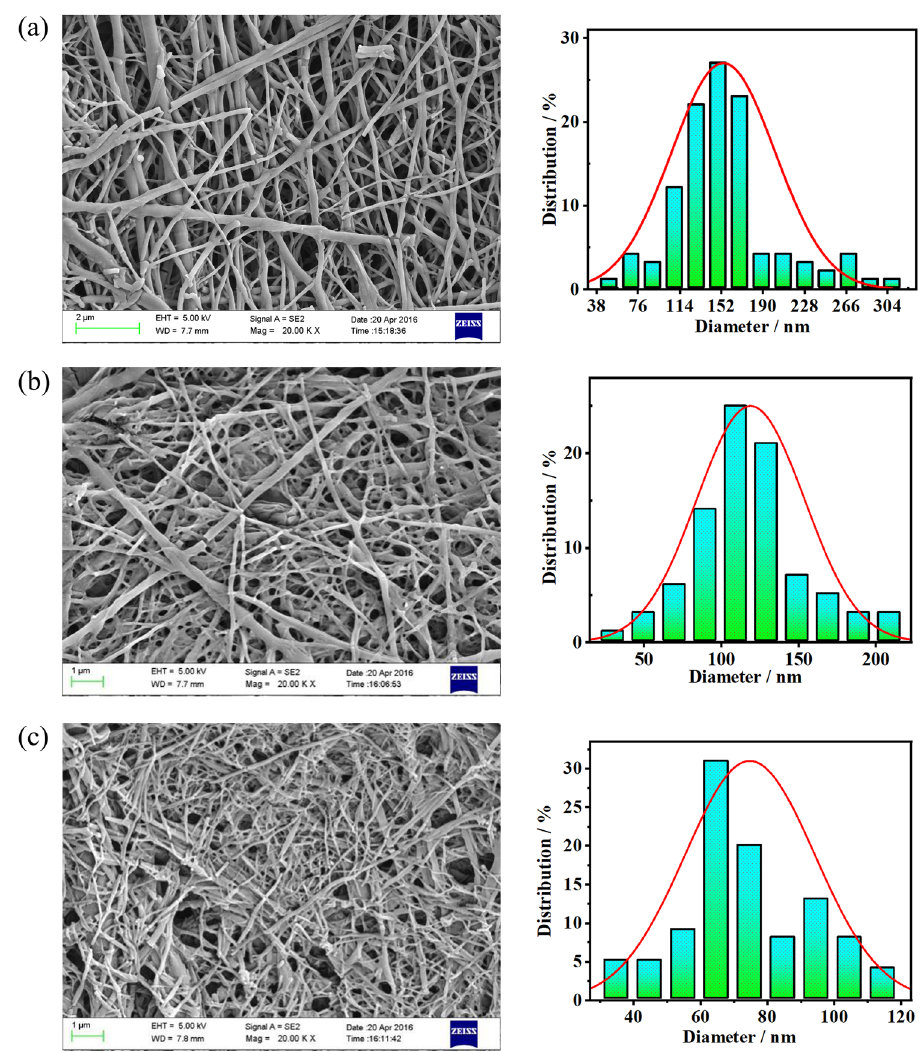
Figure 8: Morphology of the PLA nano fi bers and diameter distribution of the nano fi bers fabricated using PVA/PLA blends with di ff erent blend ratios: ( a ) PVA/PLA ( PVA 70 wt% ) , ( b ) PVA/PLA ( PVA 80 wt% ) , and ( c ) PVA/PLA ( PVA 90 wt% )